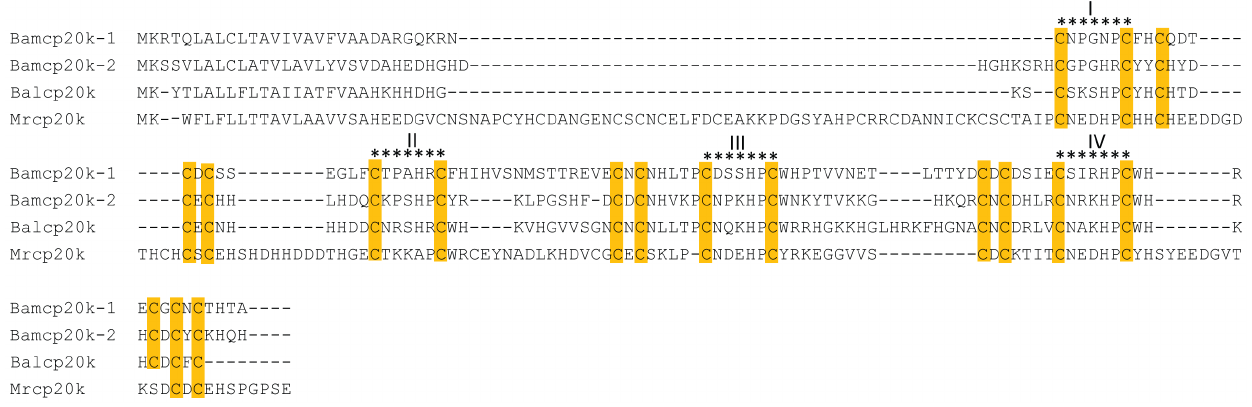
Figure 2. Alignment of the homologues of cp20k. Amphibalanus amphitrite cp20k-1 (Bamcp20k-1, JX826508) and cp20k-2 (Bamcp20k-2, JX826509) together with Fistulobalanus albicostatus cp20k (Balcp20k, BAF96022.1) and Megabalanus rosa cp20k (Mr cp20k, BAB18762.1) were aligned with CLUSTAL W software. Repeated Cys residues were highlighted in yellow. The motif of Cys-Xaa-Xaa-Xaa-Xaa-Xaa-Cys was indicated by asterisk. Xaa: any residue.